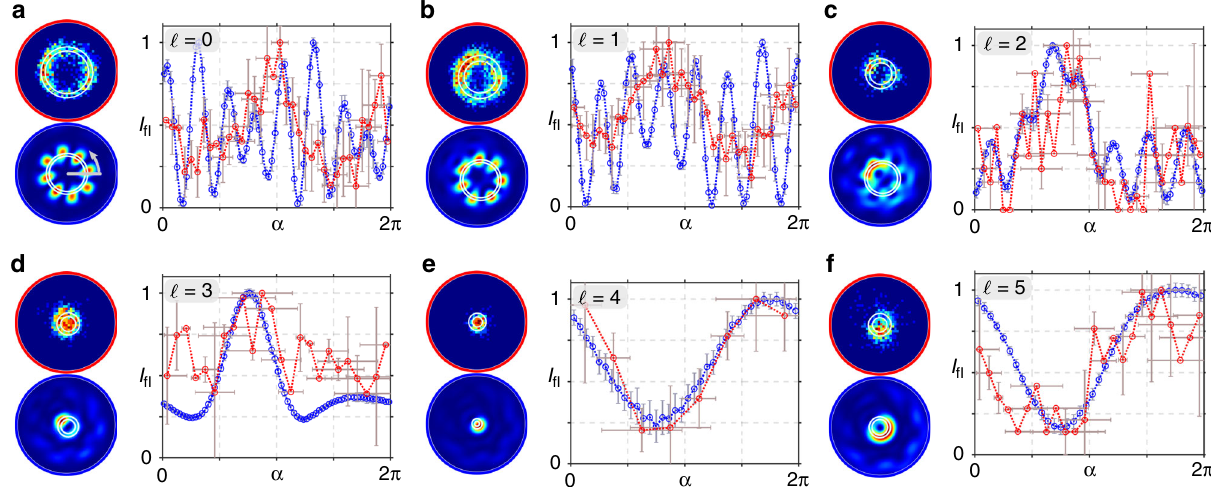
Fig. 6 Graphical analysis of fl uorescence for focused fl ower con fi gurations. a – f σ 12 = 8, ‘ ¼ f 0 ; 1 ; ¼ ; 5 g . Studied intensity images are shown to the left of each graph (experiment: red edged, simulation: blue edged). In graphs, the mean intensity I fl in an angular segment of a ring shaped subspace (white marks in intensity images) is shown in dependence of angular position α (red: experiment, blue: simulation). Intensity errors are given by standard deviation, experimental angular errors are calculated on the basis of the point spread function of the imaging